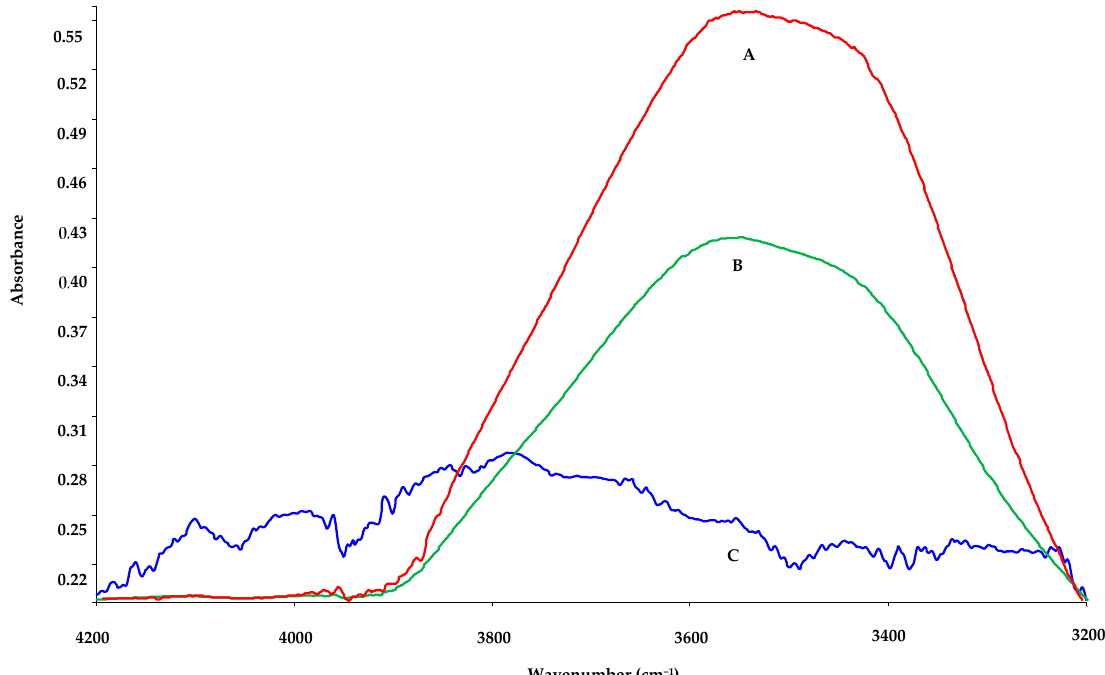
◦ C, ( B ) 550 ◦ C, ( C ) 750 ◦